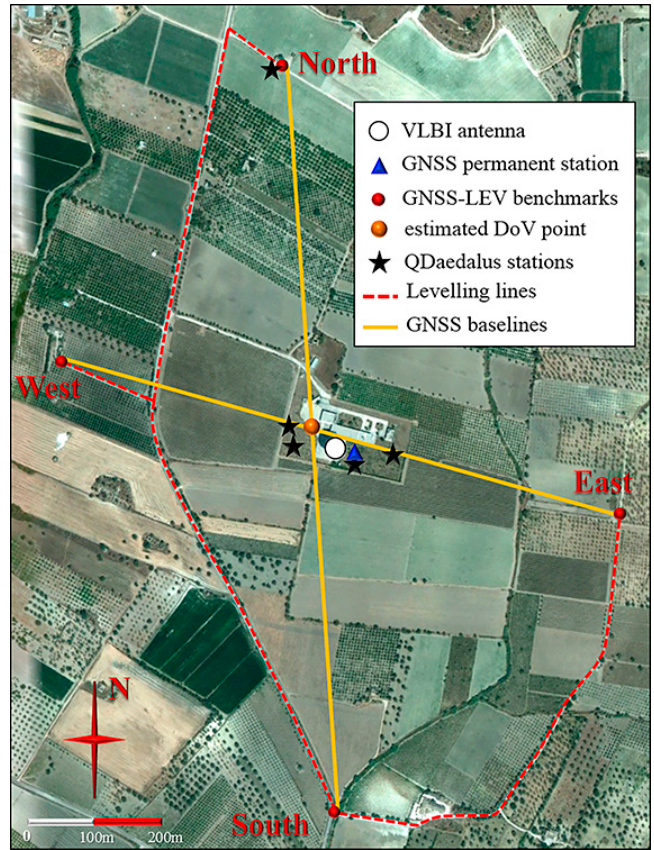
Figure 2. Area of the IRA-INAF observatory of Noto (Sicily) (satellite image courtesy of Google Earth ® ).